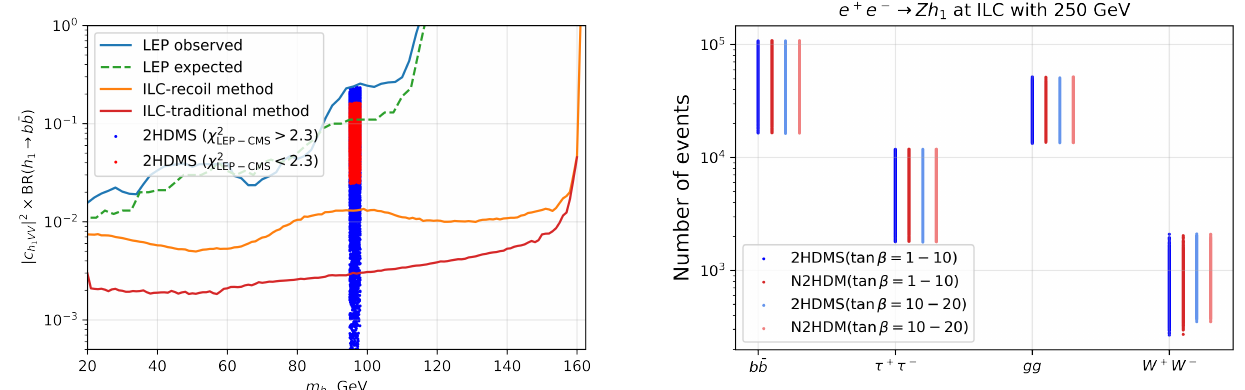
Figure 18. Left : Points in the 2HDMs that agree with both CMS and LEP excess and which can be probed at the ILC. Right : predicted rates in the 2HDMS and N2HDM at 250 GeVusing full target luminosity.